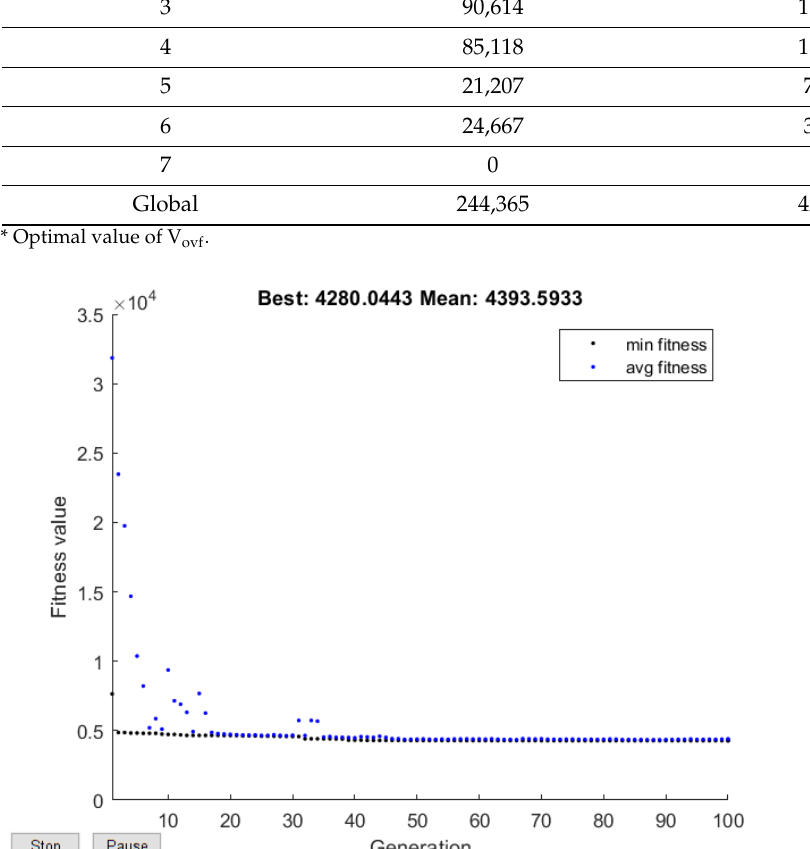
Figure 16. Best and average fitness evolution in control strategy #3 when minimizing OQI. Table 12. Simulation results when the overflow quality index is minimized (strategy